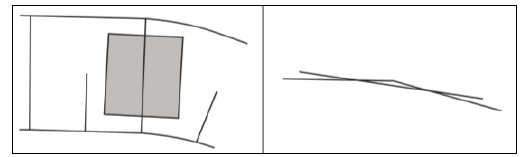
Figure 12. Principle sketches of the terrain kink and adjusted